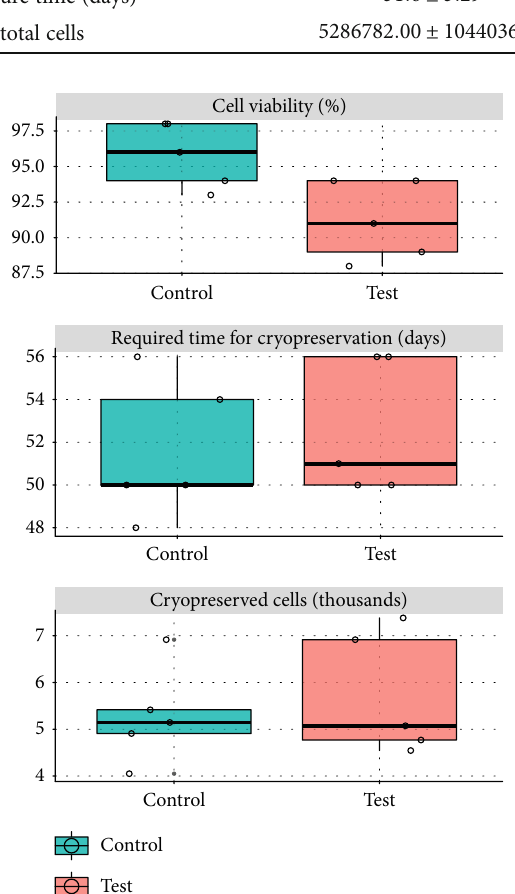
Figure 5: Boxplot with the values obtained in each sample for the control and test